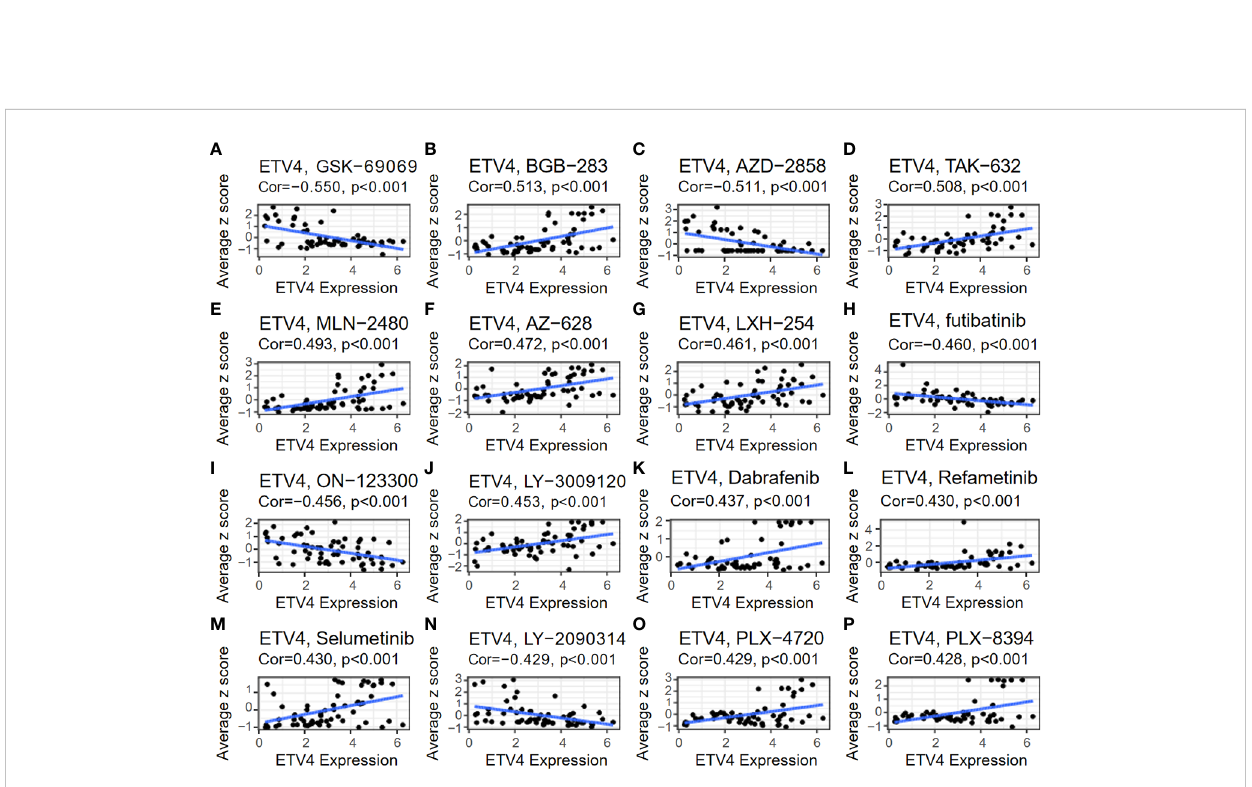
FIGURE 9 Relationship between ETV4 levels and drug sensitivity. The expression level of ETV4 was correlated with the drug sensitivity of (A) GSK-690693, (B) BGB-283, (C) AZD-2858, (D) TAK-632, (E) MLN-2480, (F) AZ-628, (G) LXH-254, (H) Futibatinib, (I) ON-123300, (J) LY-3009120, (K) Dabrafenib, (L) Refametinib, (M) Selumetinib, (N) LY-2090314, (O) PLX-4720, and (P)